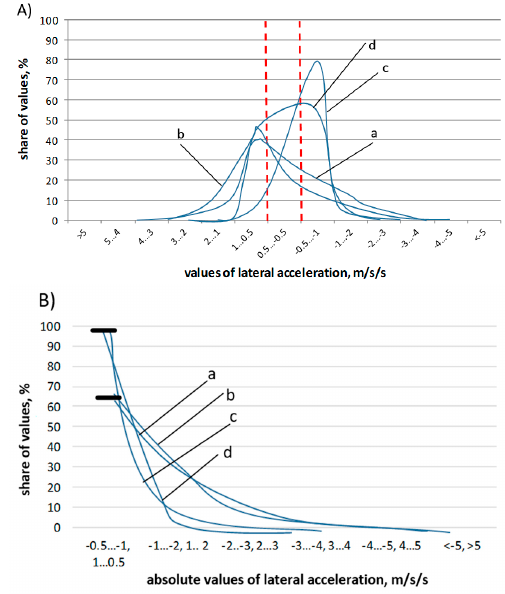
Figure 13. Breakdown of lateral acceleration values (A) and absolute values of lateral acceleration (B) on various road types: (a) urban area (city); (b) non-urban area (single roadway with two traffic lanes); (c) two-roadway expressway; (d) motorway.